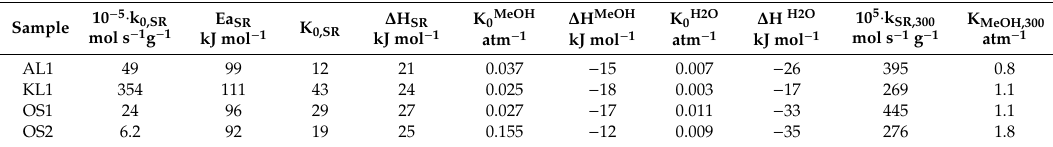
Table 4. Langmuir-Hinshelwood (LH) Model parameter